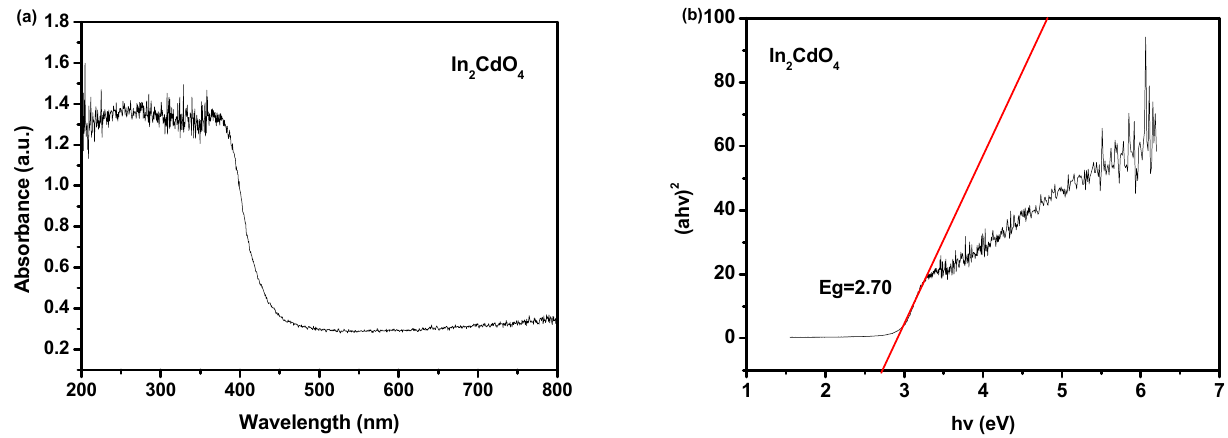
Figure 5. ( a ) UV − Vis diffuse reflectance spectra of In 2 CdO 4 ; ( b ) plot of ( α h ν ) 2 versus h ν for In 2 CdO 4 .